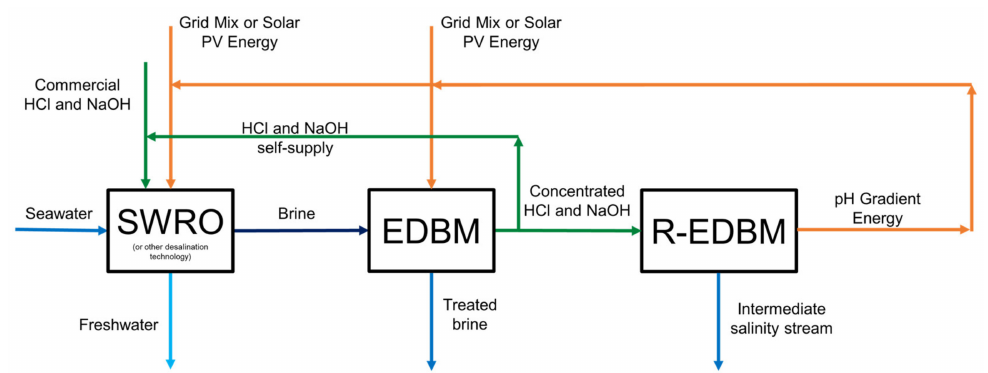
Figure 5. Alternative A3 flow